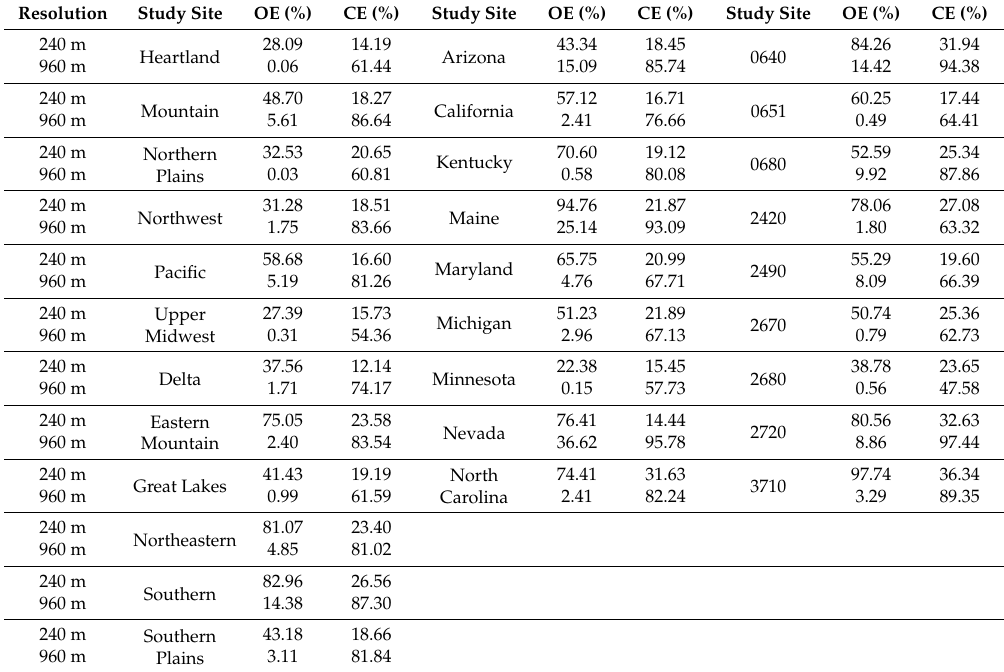
Table 8. The Omission Error (OE) and Commission Error (CE) for the crop map class in the GFSAD